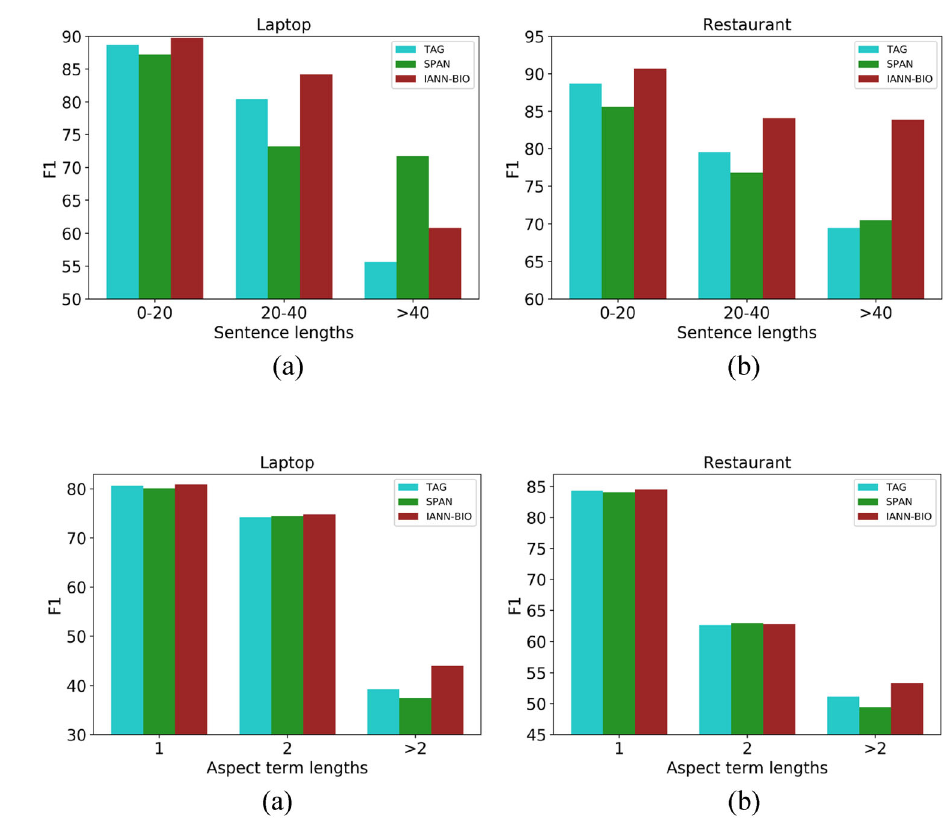
Fig. 11 F1 on laptop and restaurant w.r.t different sentence lengths. a Reports the results in the laptop dataset, b reports the results on the restaurant dataset